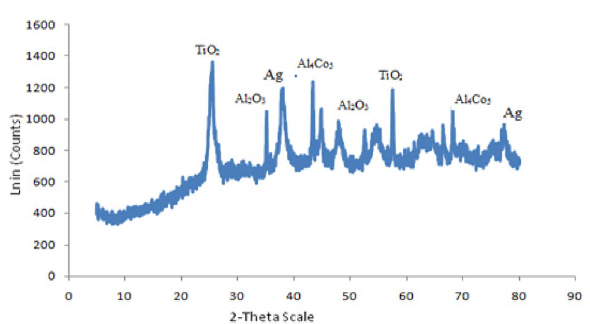
Figure 4. XRD pattern of Ag/Co 3 O 4 /TiO 2